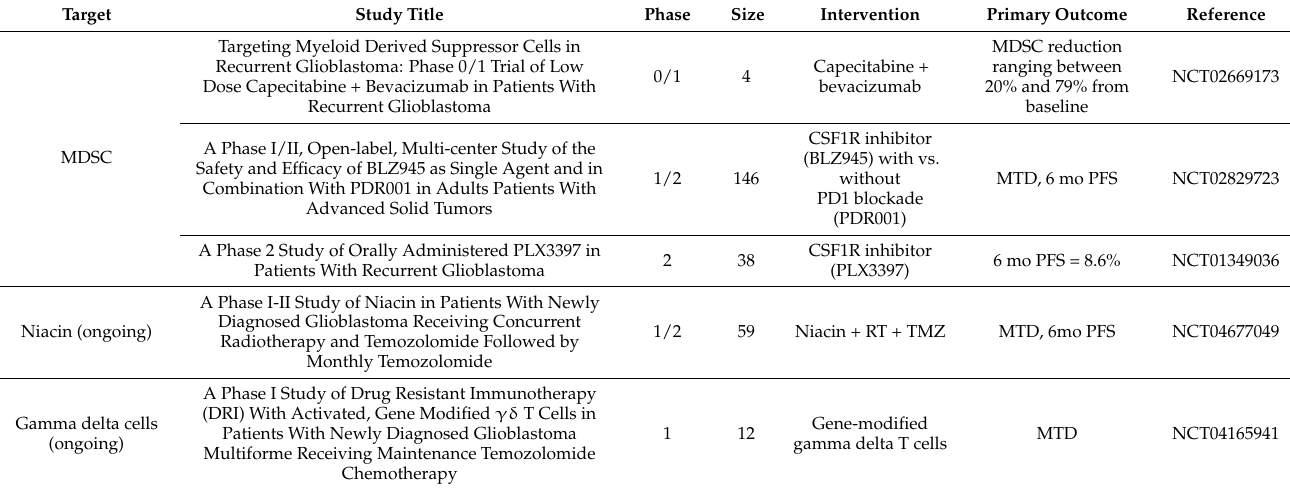
Table 7. Immunotherapy clinical trials aimed at the innate immune system for